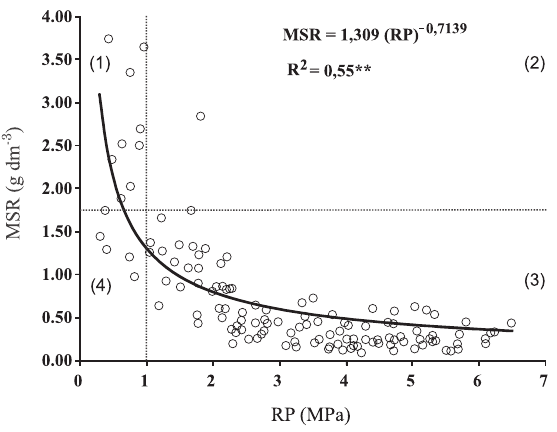
Figura 4. Relação entre a massa seca de raízes (msR) e a resistência do solo à penetração (RP), utilizando dados obtidos em todos os tratamentos e as camadas de solos estudadas. os números de 1 a 4 indicam o quadrante. o símbolo ** indica que o modelo ajustado foi significativo (F <